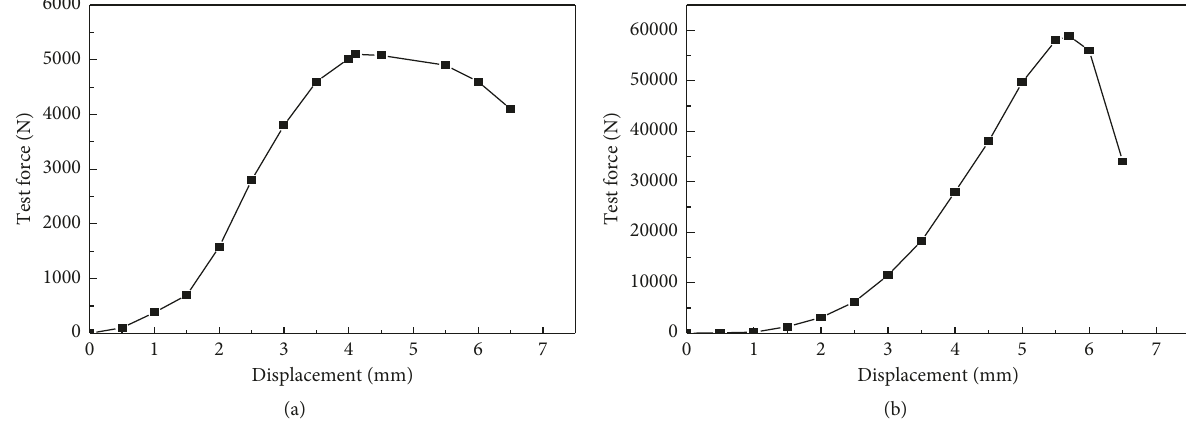
Figure 15: Comparison of test results from load-displacement curves. (a) Room temperature. (b) Low